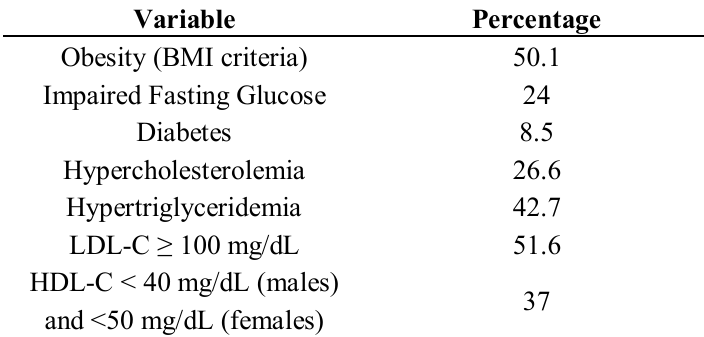
Table 4. Prevalence of obesity and cardio-metabolic risk factors in urban population of New Delhi, India ( n = 459).